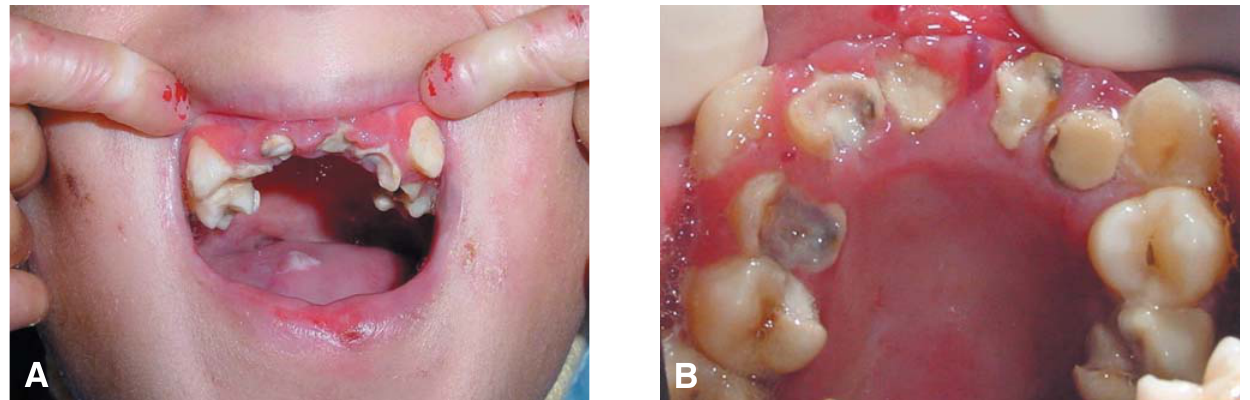
FIGURE 1- A= Frontal view of open mouth with patient’s help. The limitation of mouth opening was a consequence of microstomia. B = Maximal upper occlusal view